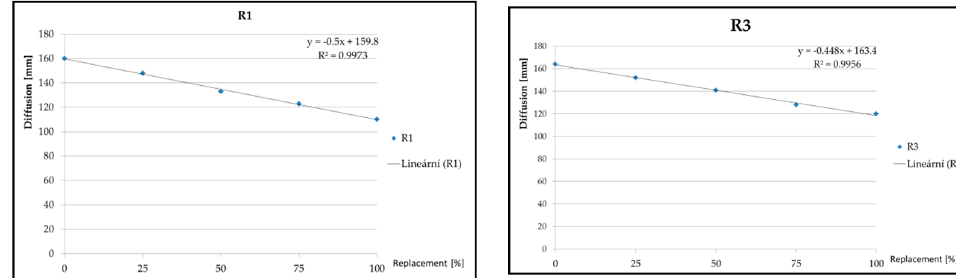
Figure 3. Linear dependence of the diffusion value of Formulas R1 and R3 on the replacement of mixing water with waste sludge water from the concrete plant.